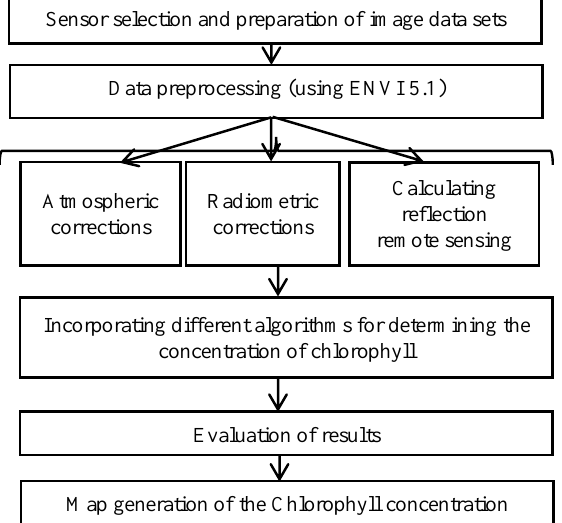
Figure 2. Different stages of selecting the best algorithm Data of Landsat 8 were downloaded and processed using ENVI 5.1 software. Also, atmospheric correction is performed by FLAASH for each image data set. The output of this stage Rrs corrected for each pixel in bands 1 to 7, which it values is applied at each of the algorithms in this paper (i.e. OC2, OC3, OC4, two- band approach and three-band approach algorithms).